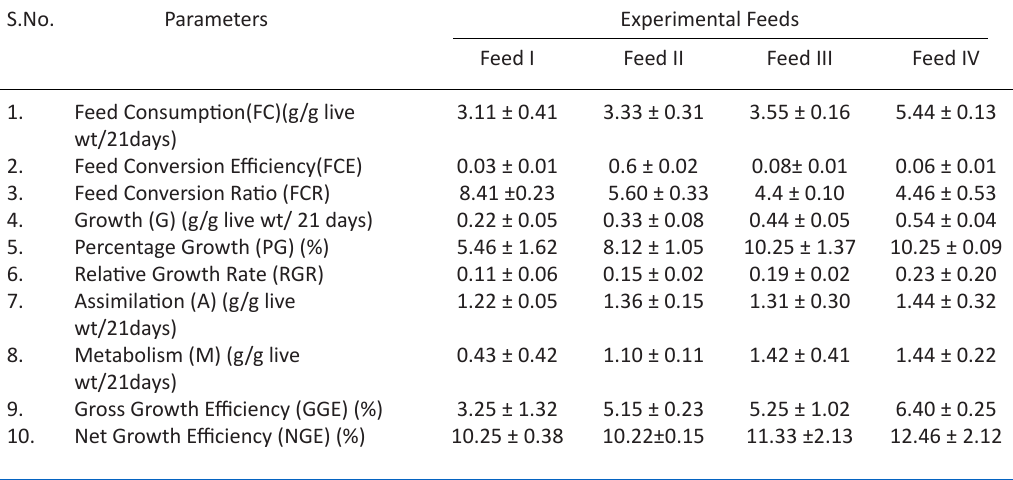
Table 8. Feed utilization and Growth parameters of Blue Gourami in relation to different bacteria. Each value is the average (±SD) performance of 5 individuals in triplicates reared for 21 days S.No.